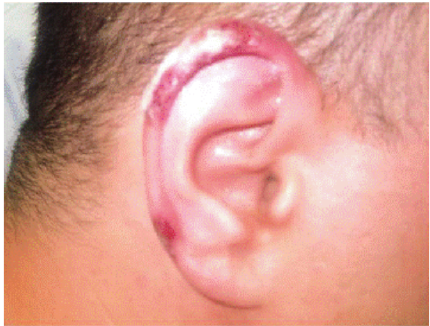
Figure 1: Tender and purpuric lesions with mild skin necrosis on the helical rim of the right